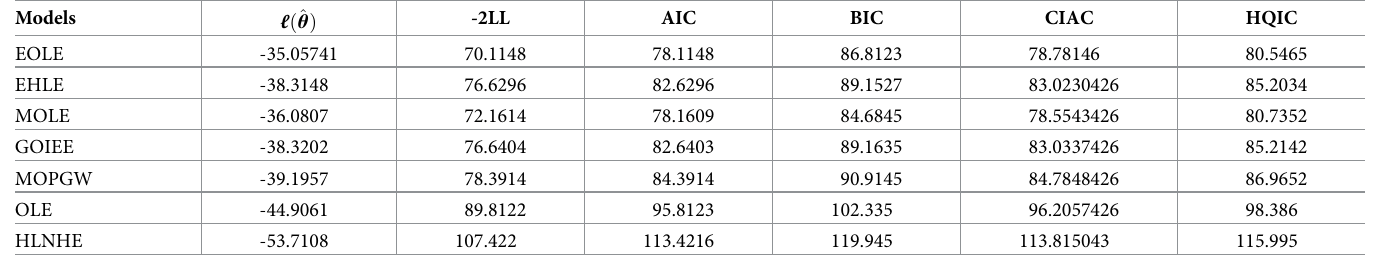
Table 9. Comparison of -2LL, AIC, BIC, CIAC, and HQIC value among models. Models